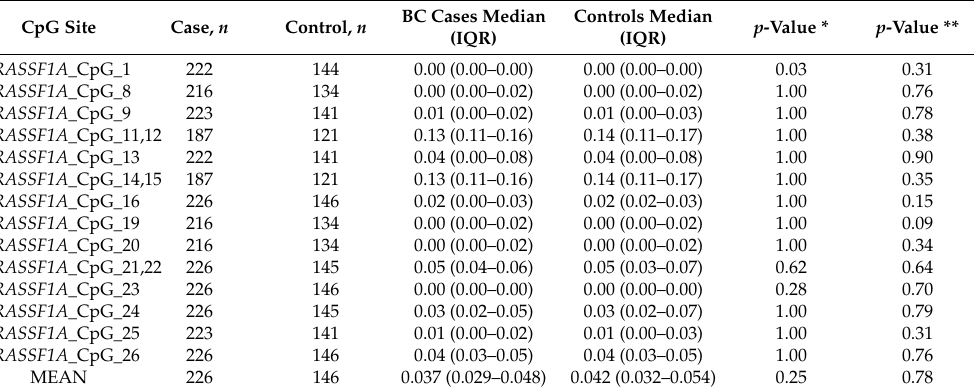
Table 1. Comparison of RASSF1A DNA methylation between the BC patients and the healthy controls in peripheral blood.